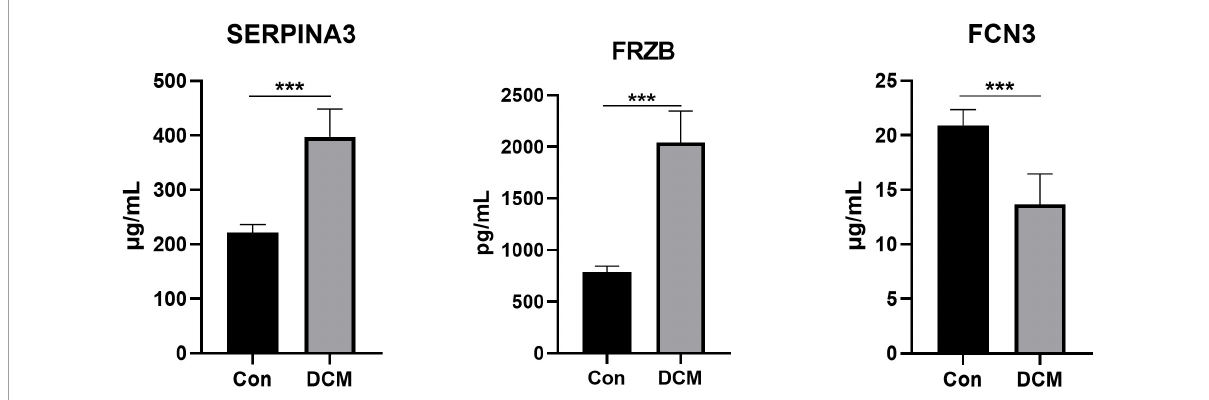
FIGURE8 The plasma levels of SERPINA3, FRZB, and FCN3 in dilated cardiomyopathy (DCM) patients and healthy controls. ***Mean P <